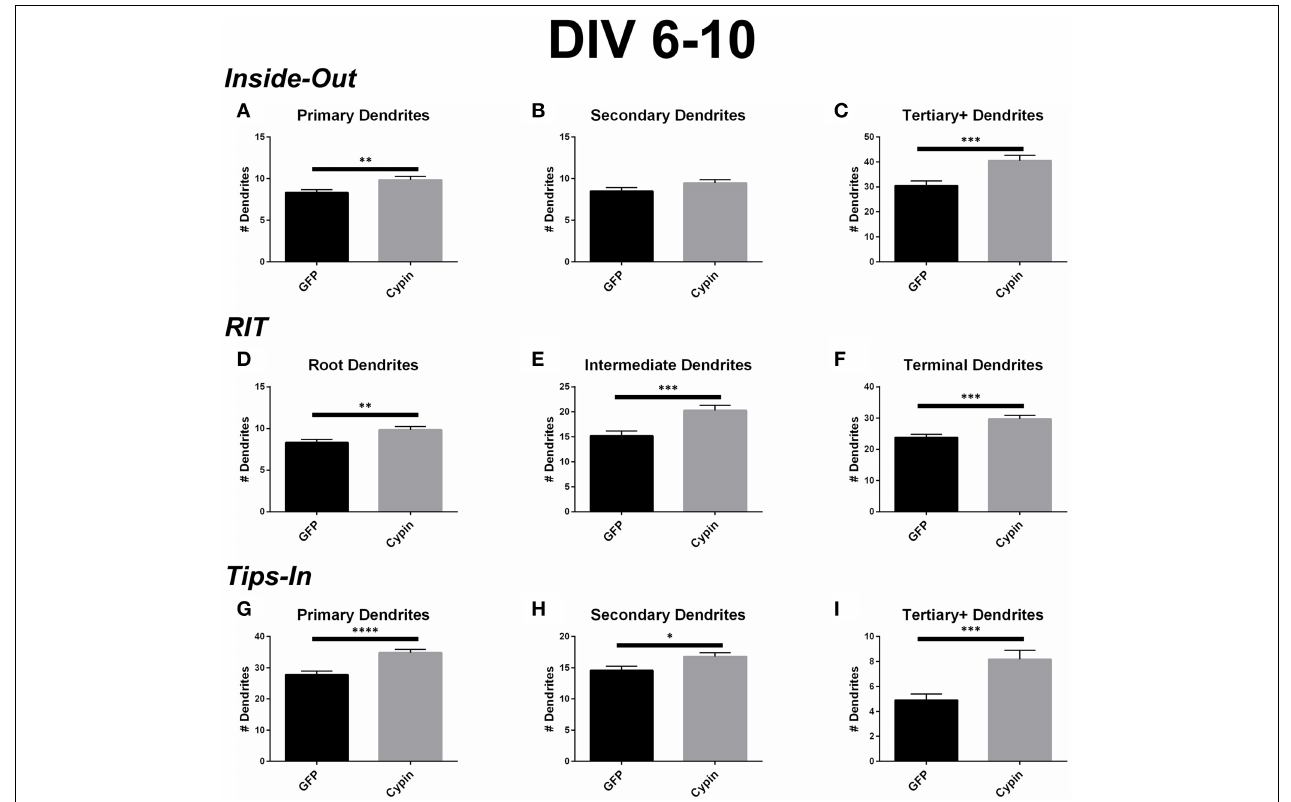
FIGURE 4 | Cypin increases the number of dendrites by specifically targeting certain categories of dendrites when overexpressed in neurons from DIV 6–10. (A–C) Dendrite numbers divided into categories using Inside-Out (conventional) labeling method. (A) Overexpression of cypin significantly increases the number of primary dendrites ( ** p < 0 . 01 ). (B) Overexpression of cypin does not significantly increase the number of secondary dendrites. (C) Overexpression of cypin significantly increases the number of tertiary and higher order dendrites ( *** p < 0 . 001 ). (D–F) Dendrite numbers divided into categories using RIT labeling method. (D) Overexpression of cypin significantly increases the number of root dendrites ( ** p < 0 . 01 ).